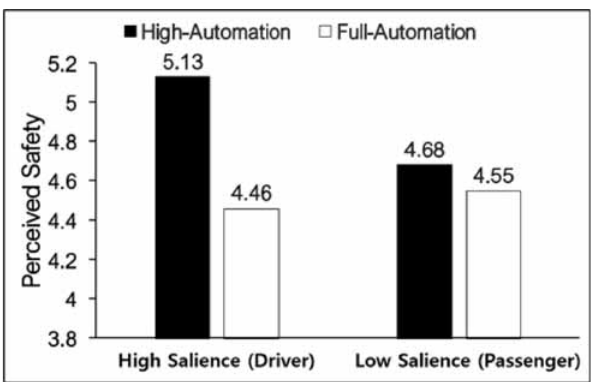
Fig. 3. Perceived safety by automation level and salience of having control (study